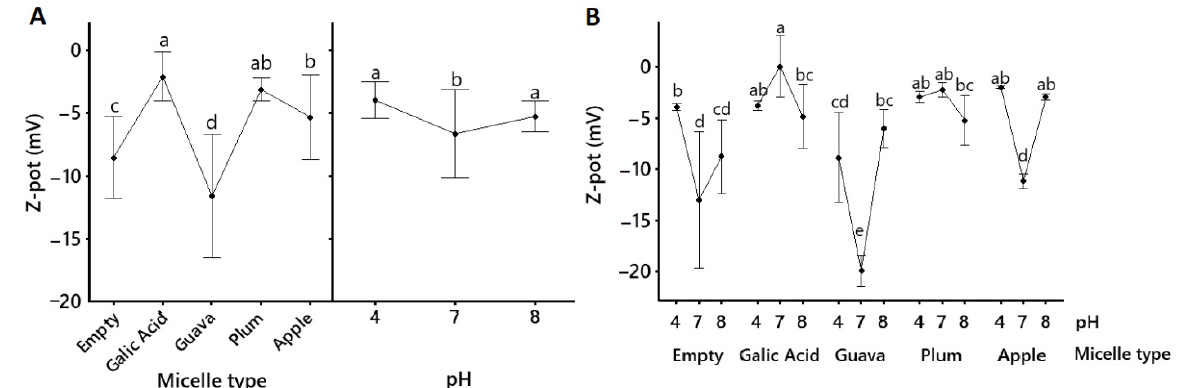
Figure 3. Mean values (mean ± 95% confidence interval, n = 6) for the ζ potential (Z-pot) of pure gallic acid and apple peel ( M. domestica cv. Anna), plum ( P. domestica cv. Satsuma), and guava ( P. guajava L.) fruit extracts that were solubilized into polysorbate-based micellar formulations. Lines connect mean values. Empty refers to a non-loaded micellar formulation. Inserts within ( A ) show the mean size of each micellar formulation (regardless of the pH) on the right and the mean size of all micellar formulations (regardless of the content) on the left; (B) shows mean size depending on pH and micelle content. Statistical differences between the type of micellar fruit extract, the pH, and the type of micellar fruit extract x pH were determined using a General Lineal Model, followed by Bonferroni´s multiple comparison post ‐ hoc tests, and they are indicated by superscript letters ( p < 0.05) (Minitab v.19.1.1.,